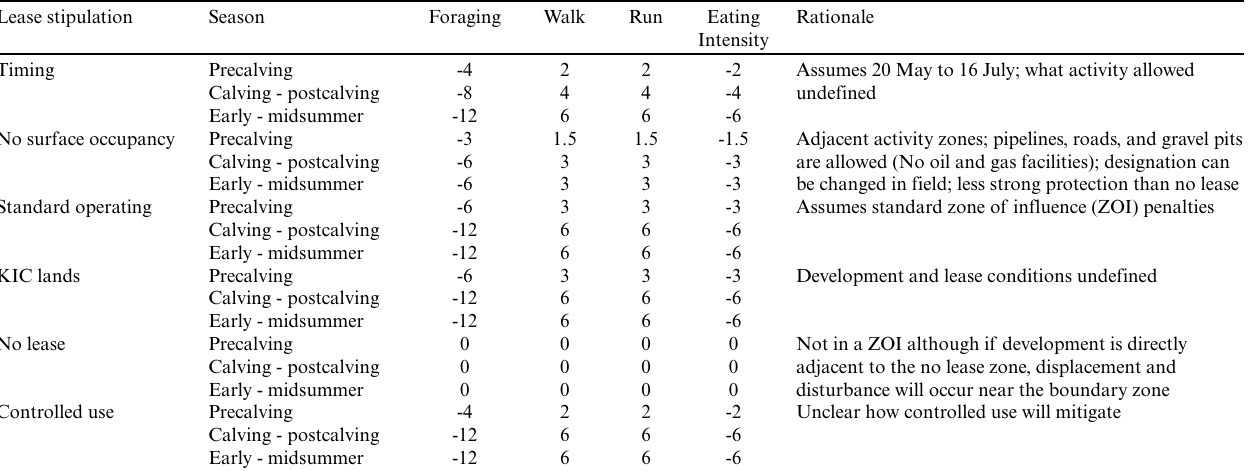
Table 1 . Penalties (percent changes) in baseline activity budgets used in the caribou cumulative effects (CCE) model based on mitigations outlined under different lease stipulations. “KIC” is Kaktovik Inupiat Land, native village corporation holdings within 1002 lands. Lease